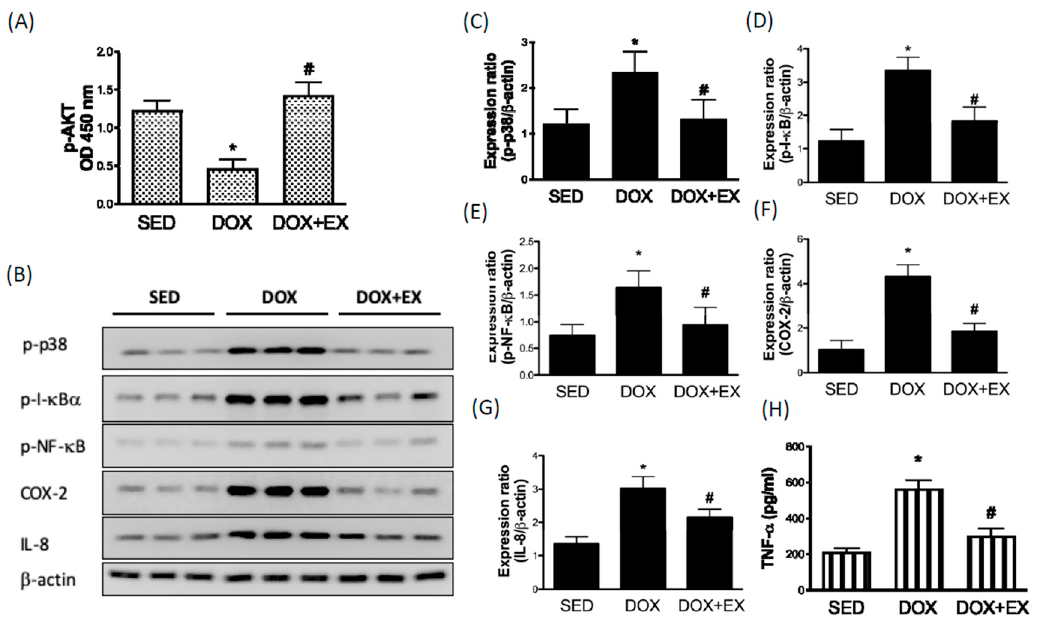
Figure 1. The effect of treadmill exercise on the DOX-induced AKT inhibition and up-regulation of inflammatory responses The phosphorylated AKT levels in cardiac tissues were investigated by ELISA ( A ). Representatives of Western blot ( B ), and the densitometric analysis of phosphorylated p38 ( C ), I κ B α ( D ), NF- κ B ( E ), COX-2 ( F ), and IL-8 ( G ). TNF- α levels were investigated by ELISA ( H ). * p < 0.05 compared to the SED group. # p < 0.05 compared to the DOX group. Detailed information